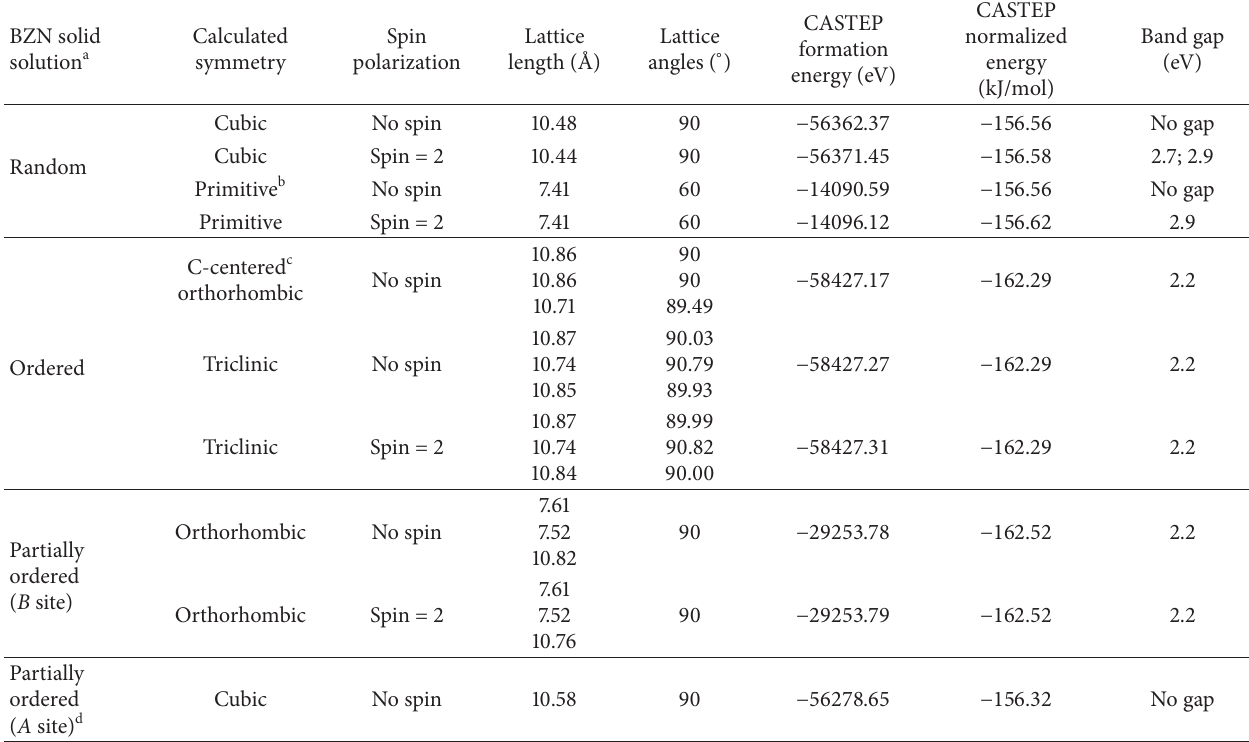
Table 2: Comparison of parameters obtained with DFT-GGA calculations for BZN random, ordered, and partially ordered solid